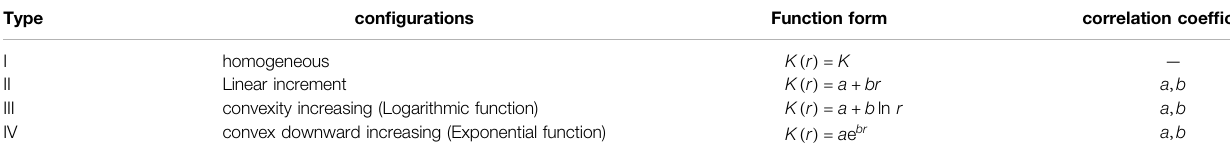
TABLE 1 | Function form of different permeability con fi gurations.